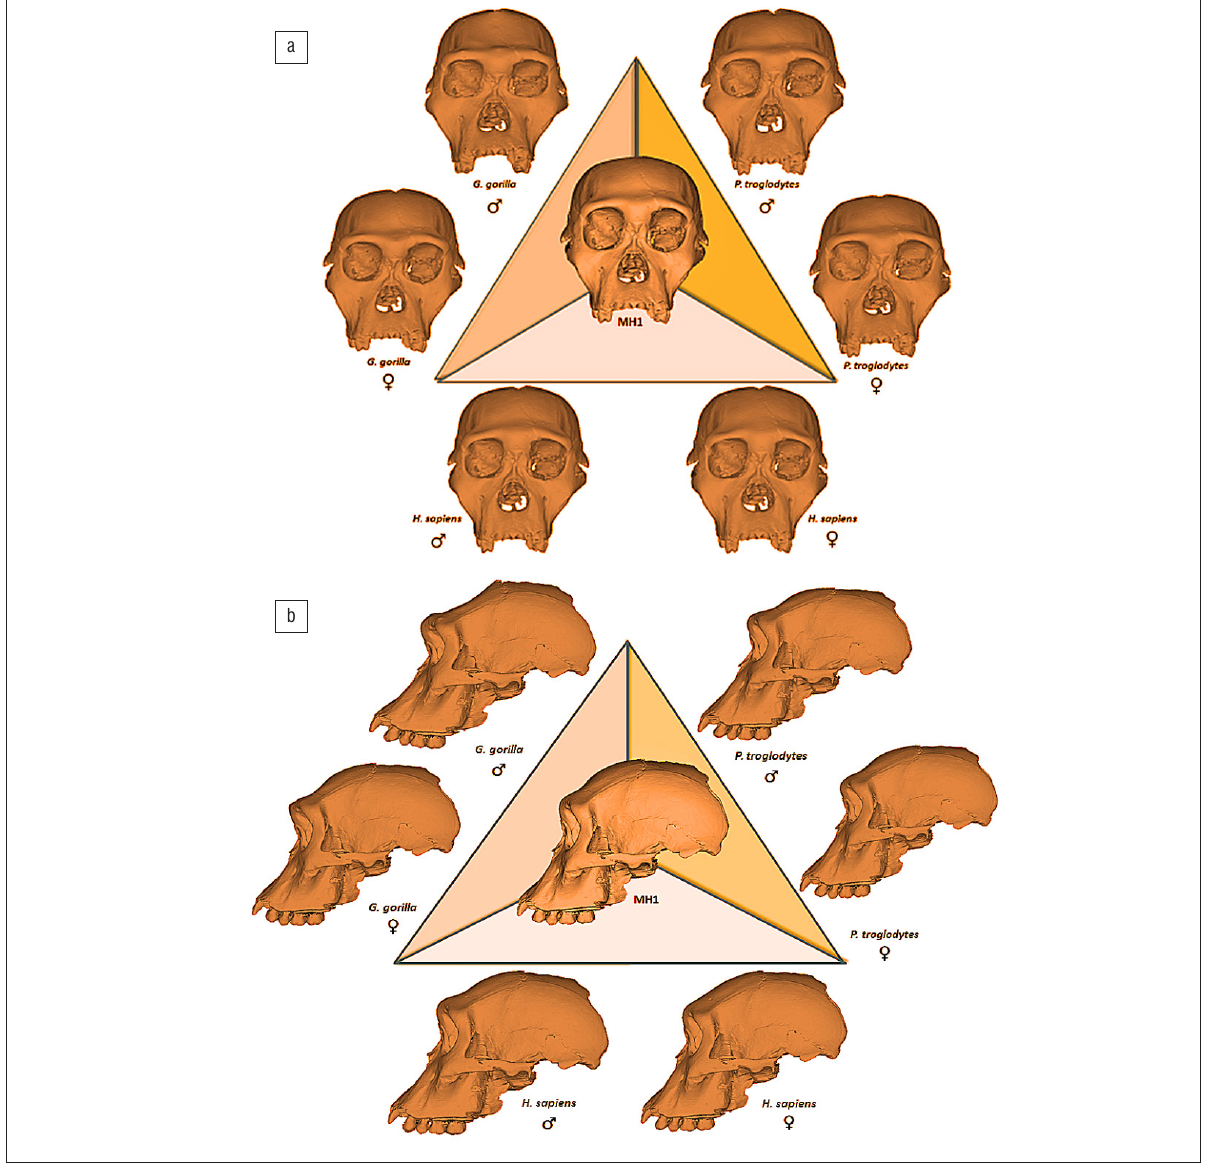
Figure 2: Visualisations of MH1 and its simulated adult forms from hominoid developmental trajectories in (a) frontal and (b) lateral